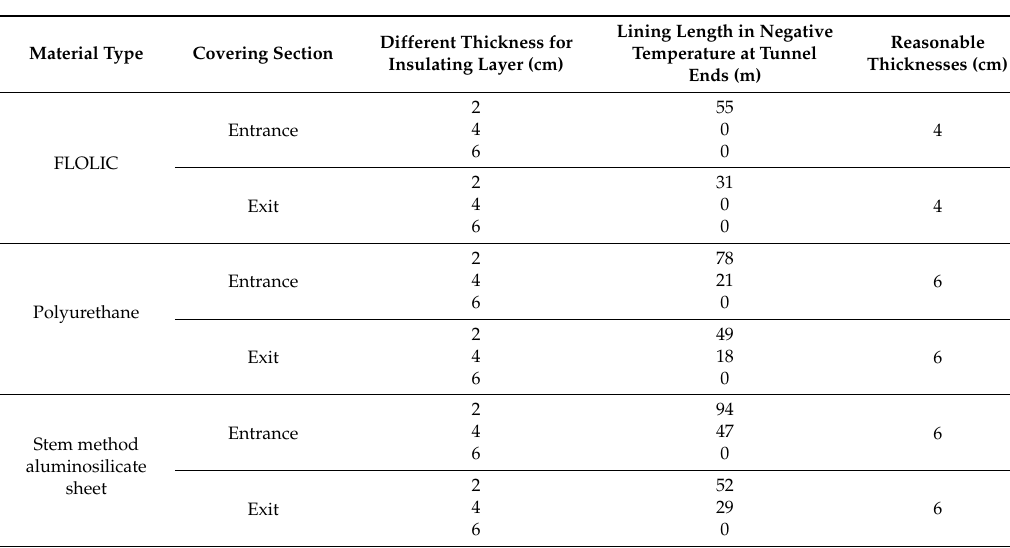
Table 3. Optimization of design thickness for different heat-insulating